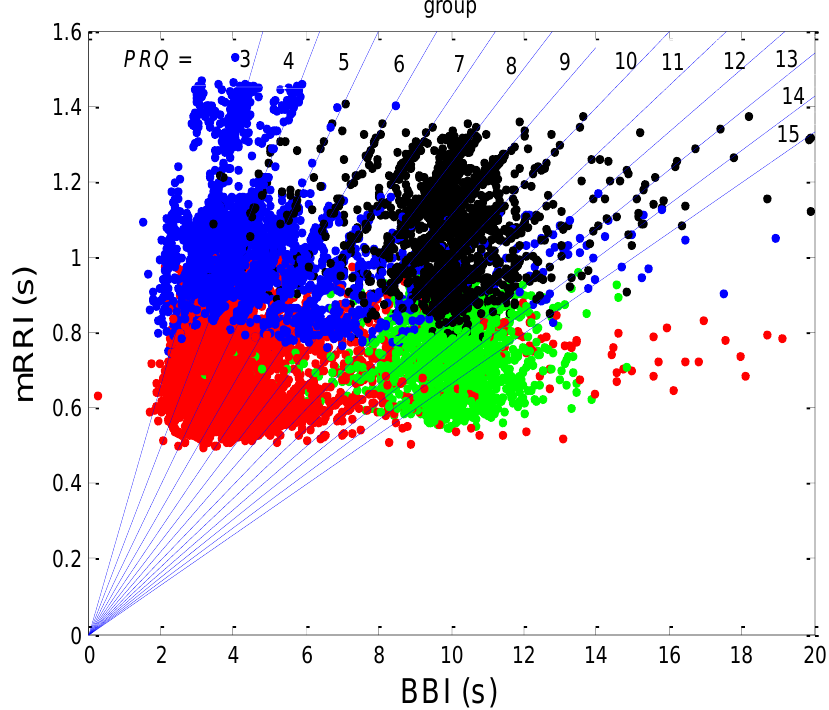
Figure 8. Group scatter plot of respiratory BBI vs. mRRI (averaged RRI within each BBI ), obtained by superimposing separate scatter plots of all twenty subjects in all four states (supine — blue; standing — red; supine with slow 0.1 Hz breathing — black; standing with slow 0.1 Hz breathing — green). The concurrent PRQ int lines are also plotted.